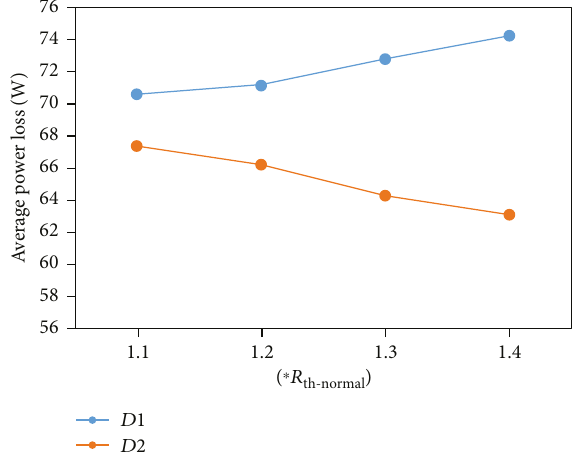
Figure 12: The average power loss.